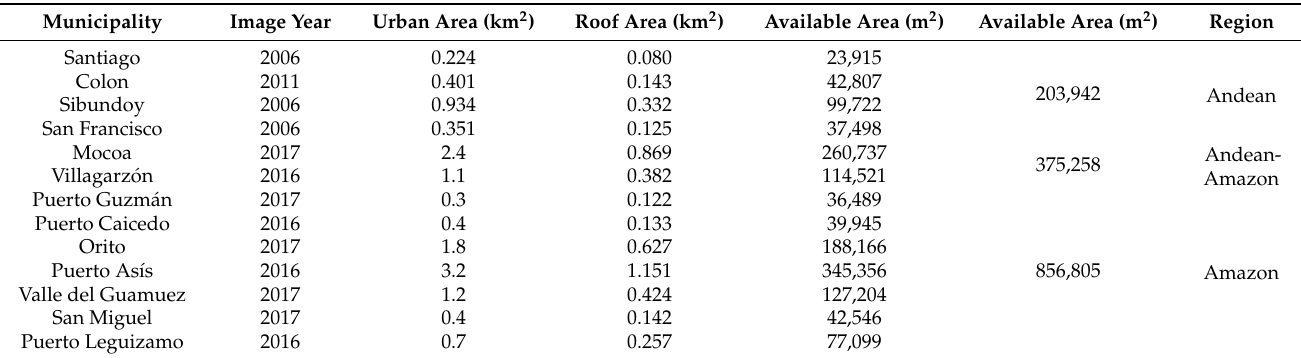
Table 7. Roofed area and percentage available for the municipalities of Putumayo according to measurements made in images available in Google Earth Pro software.